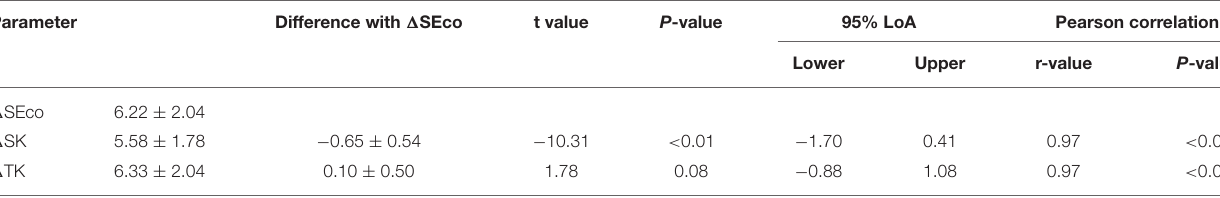
TABLE 3 | Comparison of 1 SEco, 1 SK, and 1 TK before and after myopic corneal refractive surgery. Parameter Difference with 1 SEco